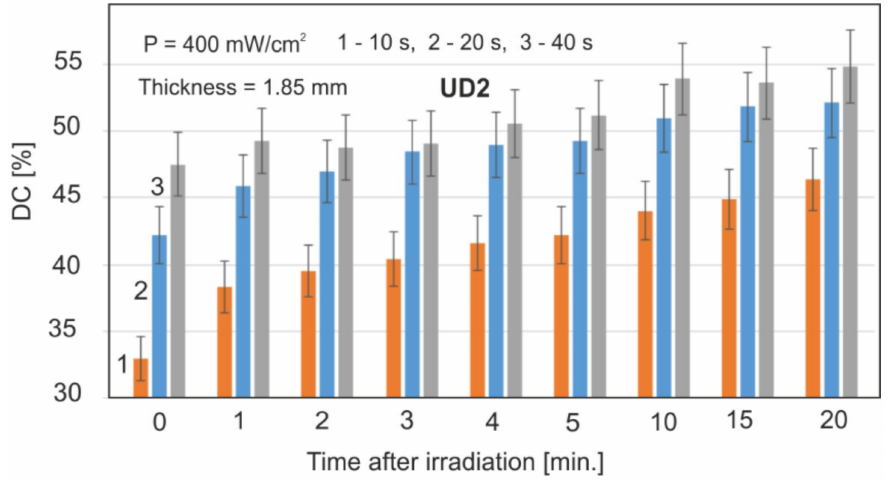
Figure 5. Effect of the exposure time on the DC